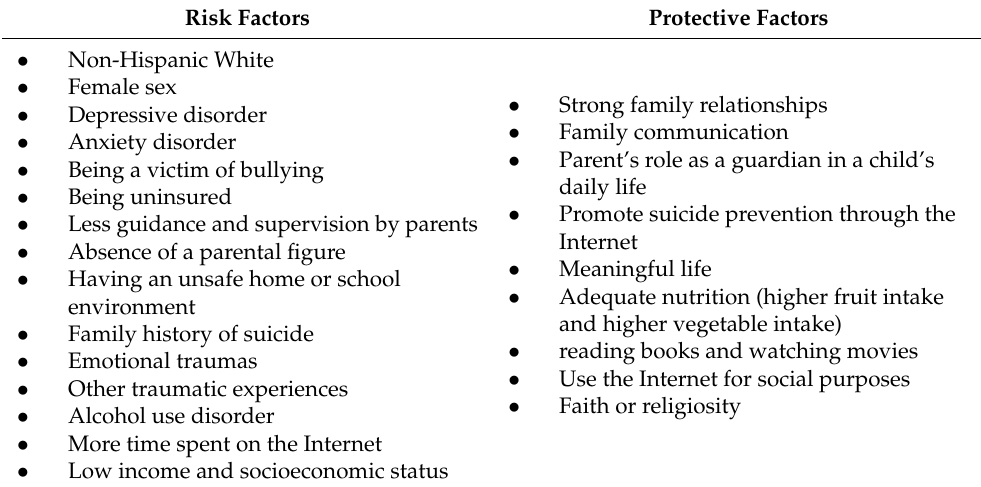
Table 1. Risk and protective factors for suicide behaviors in children and adolescents